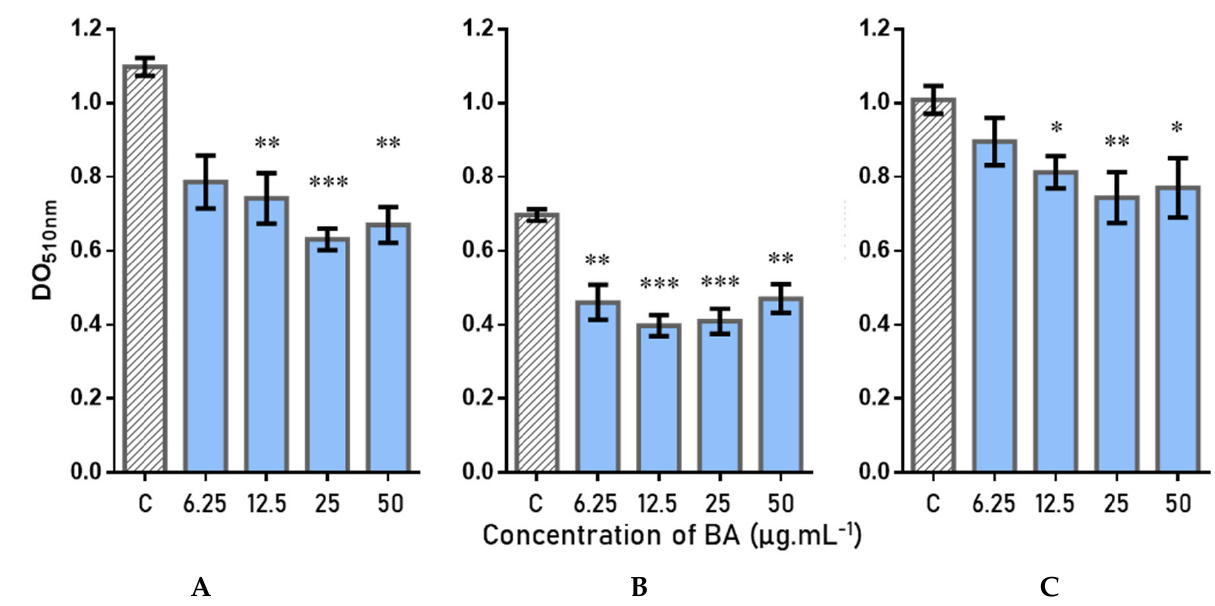
Figure 4. Betulinic acid (BA) activities on total biomass (CVS assay) of bispecies biofilm strains of C. albicans – S. aureus (error bars in SEM): ( A ) C. albicans ATCC 28367– S. aureus ATCC 29213; ( B ) C. albicans ATCC MYA-2876– S. aureus ATCC 6538; ( C ) C. albicans Aca1– S. aureus SCO4. p -values calculated by Dunn’s test were given with *: 0.05 > p -value > 0.01; **: 0.01 > p -value > 0.001; ***: 0.001 > p